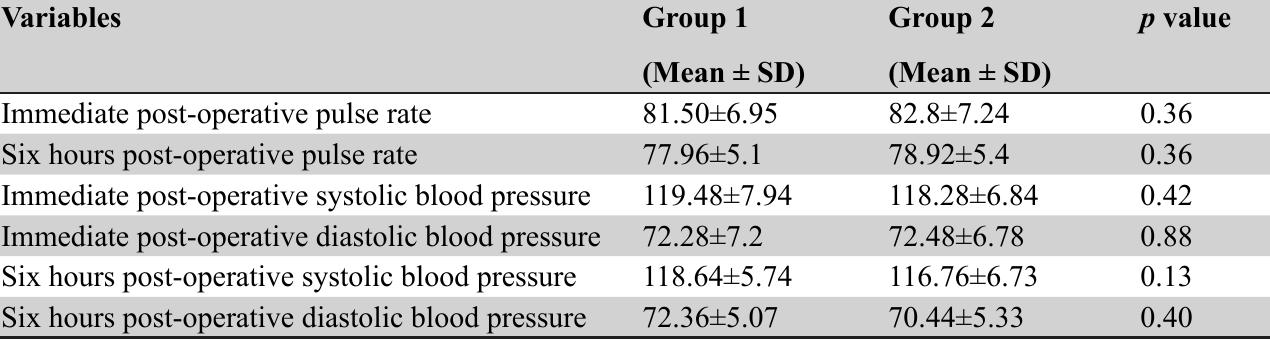
Table 4. Postoperative vital parameters (N=100).